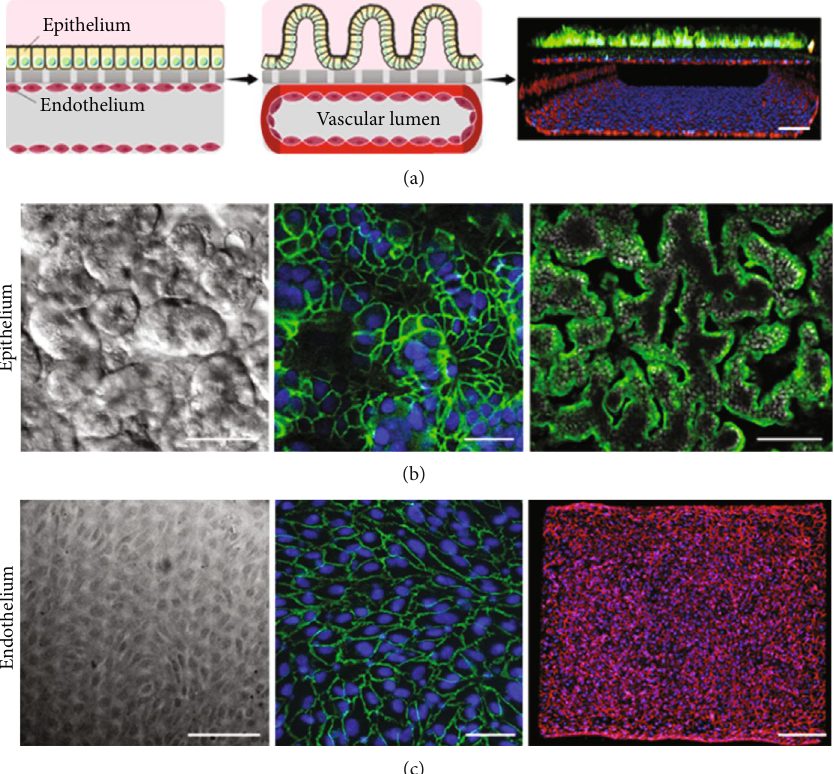
Figure 12: (a) Schematic showing the human intestinal epithelium and endothelium when initially plated on opposite sides of the matrix-coated porous membrane within the two-channel micro fl uidic device. (b) Microscopic views showing the villus morphology of the human intestinal epithelium and the immuno fl uorescence staining of the junction protein. (c) Microscopic views showing the planar morphology of the human endothelium and views of the immuno fl uorescence staining of the associated proteins. Reproduced (or adapted) with permission [84], ©2018,